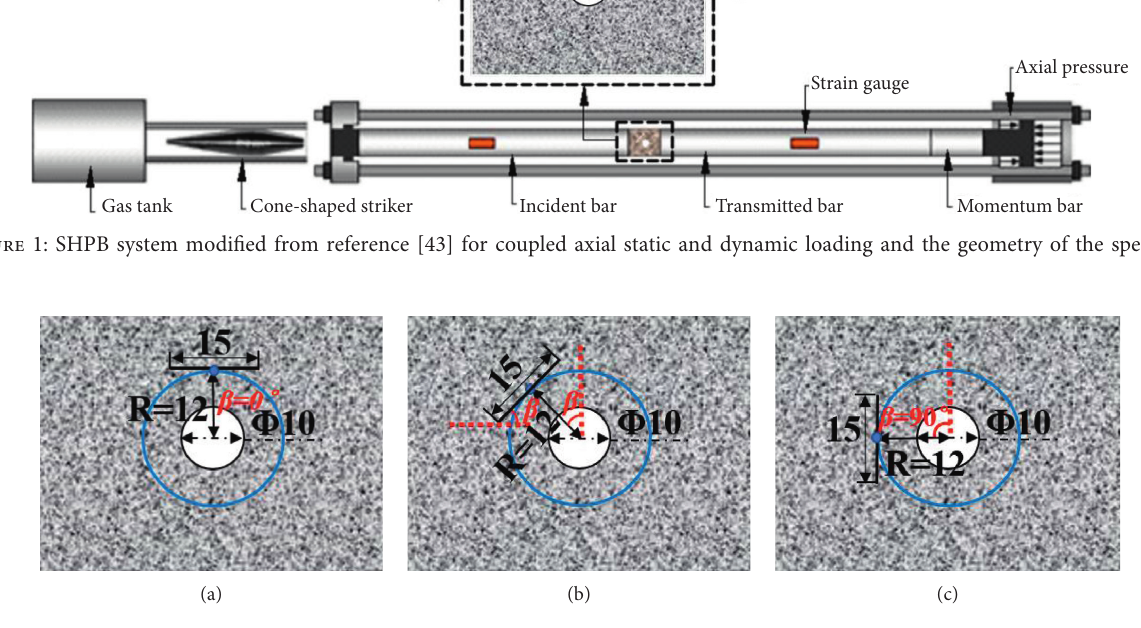
Figure 2: The layout of the combined flaws composed of crack and hole. Table 2: Geometric dimensions and mechanical parameters of granite specimens.